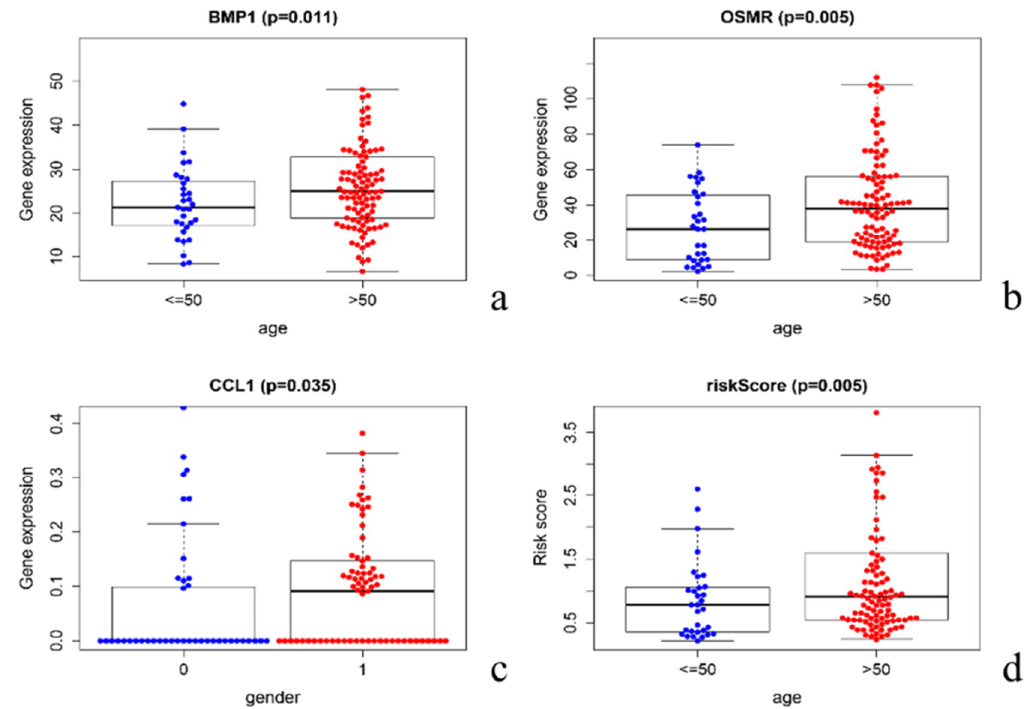
Figure 6. The expression of BMP1 (Bone Morphogenetic Protein 1) and OSMR (Oncostatin M Receptor) was related to age ( a , b ), the expression of CCL1 (C-C Motif Chemokine Ligand 1) was related to the gender ( c ), and the risk score was obviously related to age (50 years old as the age cut-off) ( p < 0.05) ( d ).